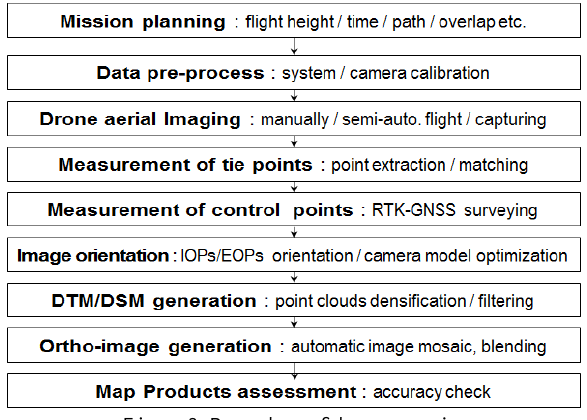
Figure 3. Procedure of drone mapping